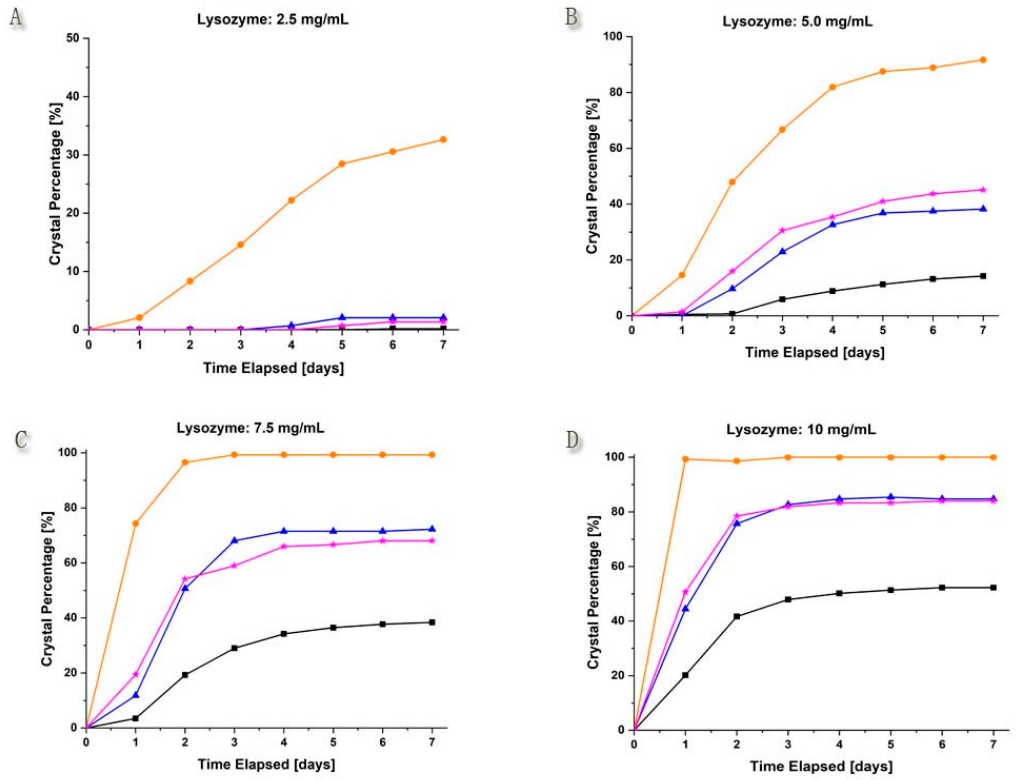
Figure 2. Crystal percentage over a period of 7 days with 5.0 mg/mL calf DNA (orange line with dots), 5.0 mg/mL salmon DNA (pink line with stars), 5.0 mg/mL herring DNA (blue line with triangles) and Blank (black line with square) at lysozyme concentration of ( A ) 2.5 mg/mL, ( B ) 5.0 mg/mL, ( C ) 7.5 mg/mL, and ( D ) 10 mg/mL at 4 °C.